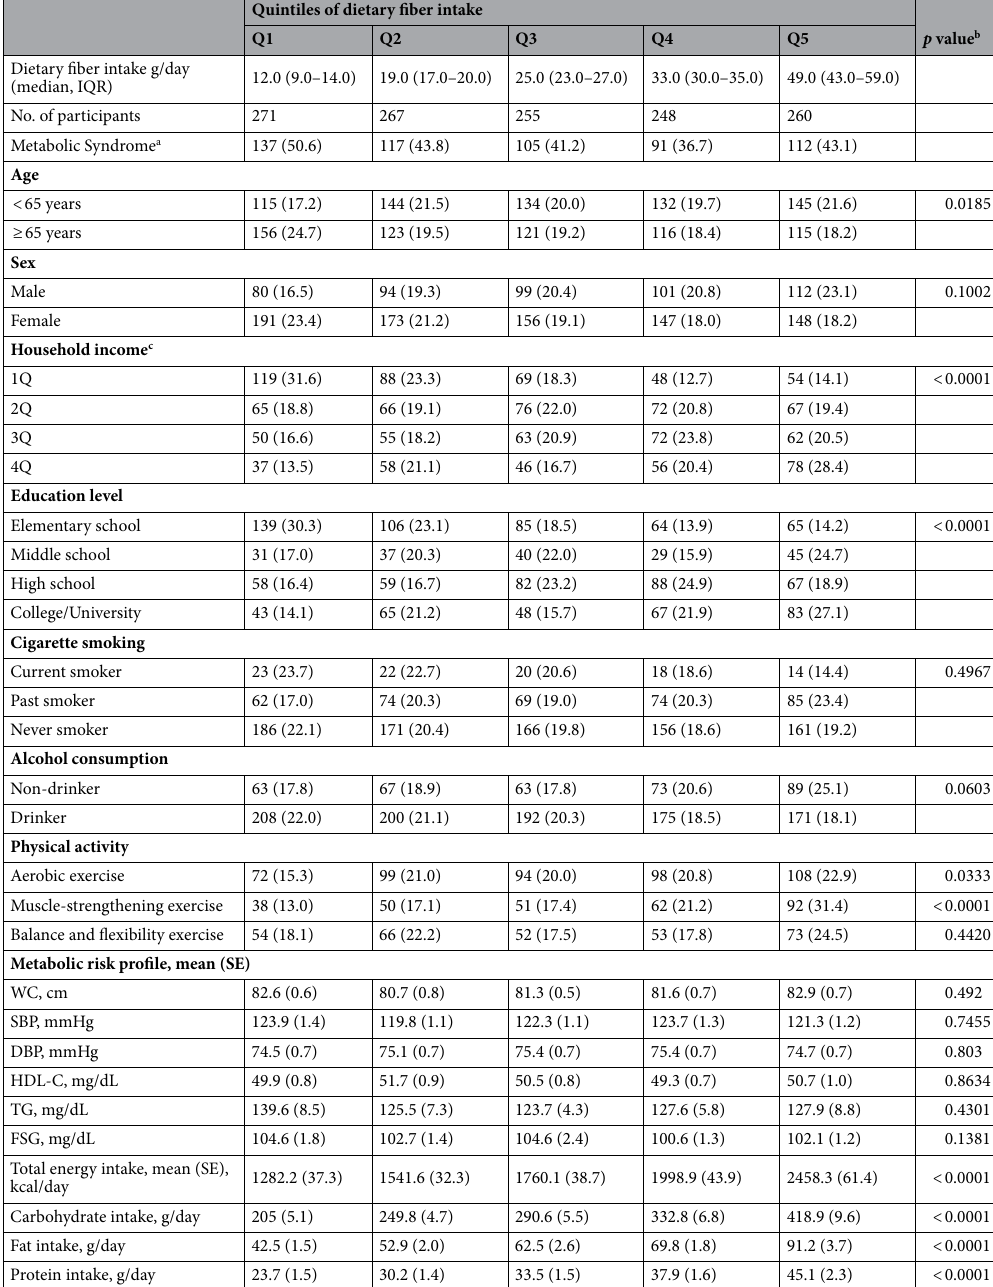
Table 1. Characteristics of adult cancer survivors according to quintile of total dietary fiber intake in the Korea National Health and Nutrition Examination Survey VI and VII (2013–2018). Values above are presented as n (%) unless otherwise specified. Q Quintile, IQR Interquartile range, SE Standard error, WC Waist circumference, SBP Systolic blood pressure, DBP Diastolic blood pressure, HDL-C High density lipoprotein cholesterol, TG Triglyceride, FSG Fasting serum glucose. a Defined from the National Cholesterol Education Program Adult Treatment Panel III (NCEP-ATPIII) modified for the Asian population. b Calculated from chi-square test for categorical variables and survey regression for continuous variables, respectively. c Proxy for socioeconomic status (calculated from the sum of the income from the members of each household divided by the square root of the number of household